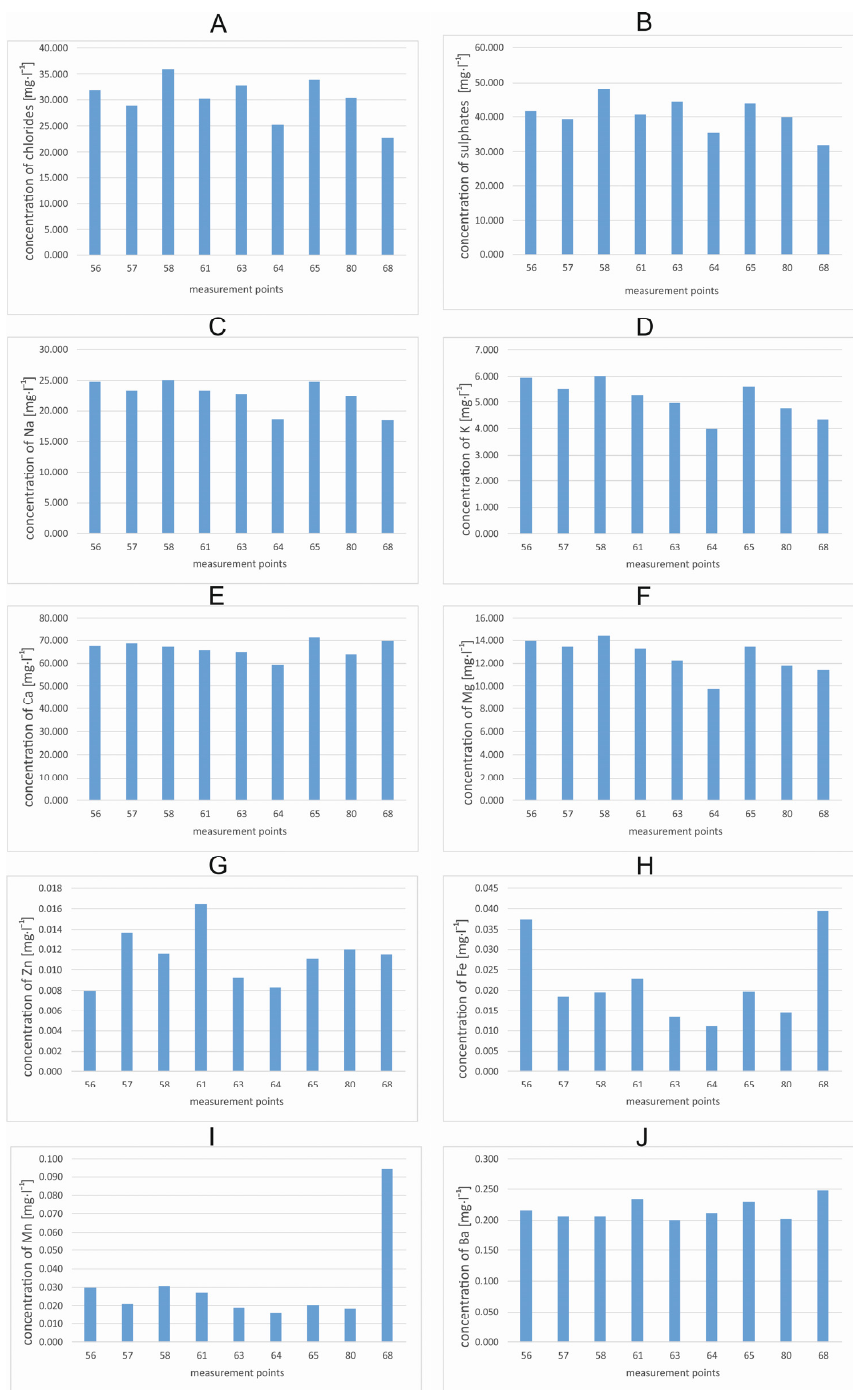
Figure 5. Variation of the annual average Concentration of chemical elements and compounds in measurement points in the water of Lake Swarz˛edzkie and Cybina river. ( A ) chlorides, ( B ) sulphates, ( C ) sodium, ( D ) potassium, ( E ) calcium, ( F ) magnesium, ( G ) zinc, ( H ) iron, ( I ) manganese, ( J ) barium. Thermal images taken from a height of about 100 m above the water surface allowed to determine the temperature differences between the water of Cybina and the water of Lake Swarz˛edzkie. 141 vertical photos were taken from a height of 100 m above the starting point, which was located near the test site. Figure 6 shows the place where individual photos were taken (blue) with the optical axis (black), the starting point (red point), outline of the reservoir (yellow line) and the generated 3D